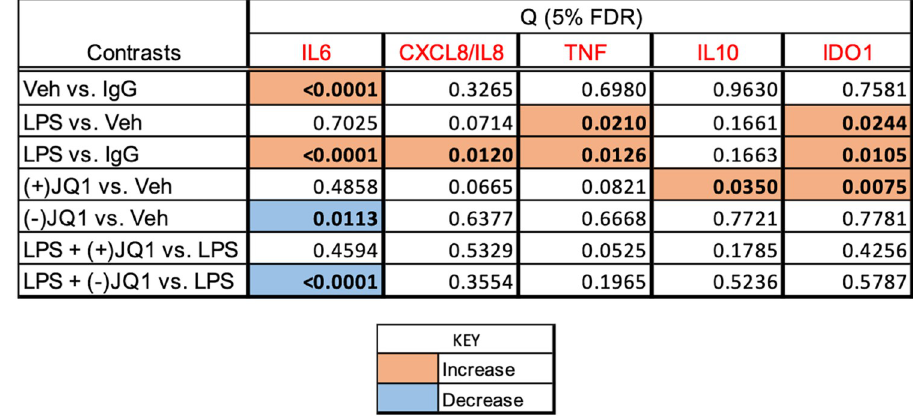
Fig 9. Heat map grid summarizing the effects of LPS, (+)-JQ, and (-)-JQ1 on histone 4 acetylation at the promoters of IL6 , CXCL8/IL8 , TNF , IL10 , and IDO1 . Culture and treatment conditions, chromatin immunoprecipitation (ChIP) details, and data processing are described in the Materials and methods section. The grid cells show significance values (Q) adjusted to the false discovery rate (FDR). The significance threshold is 5% FDR (Q < 0.05), highlighted in bold. The orange color indicates a significant increase, the blue color indicates a significant decrease in the acH3 ChIP signal regarding the contrasts shown. The gene symbols are in red. The Q values have been calculated by contrasting all treatments (21 contrasts, listed in S6 Fig). The contrasts selected for display in the heatmap indicate LPS effects (LPS vs . Vehicle), drug effects ((+)-JQ1 or (-)-JQ1 vs . Vehicle), and drug effects on the LPS response (LPS + (+)-JQ1 or LPS + (-)-JQ1 vs .